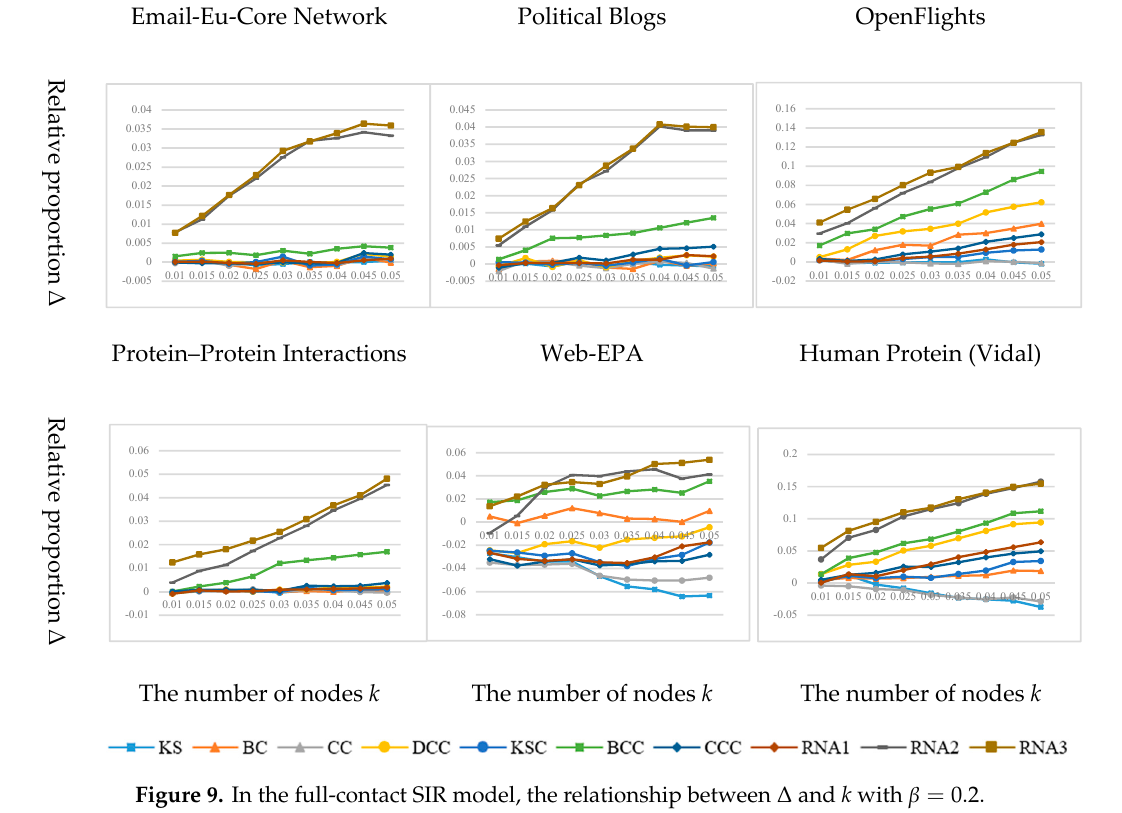
Figure 8. In the single-point contact SIR model, the relationship between ∆ and k with β = 0.2.